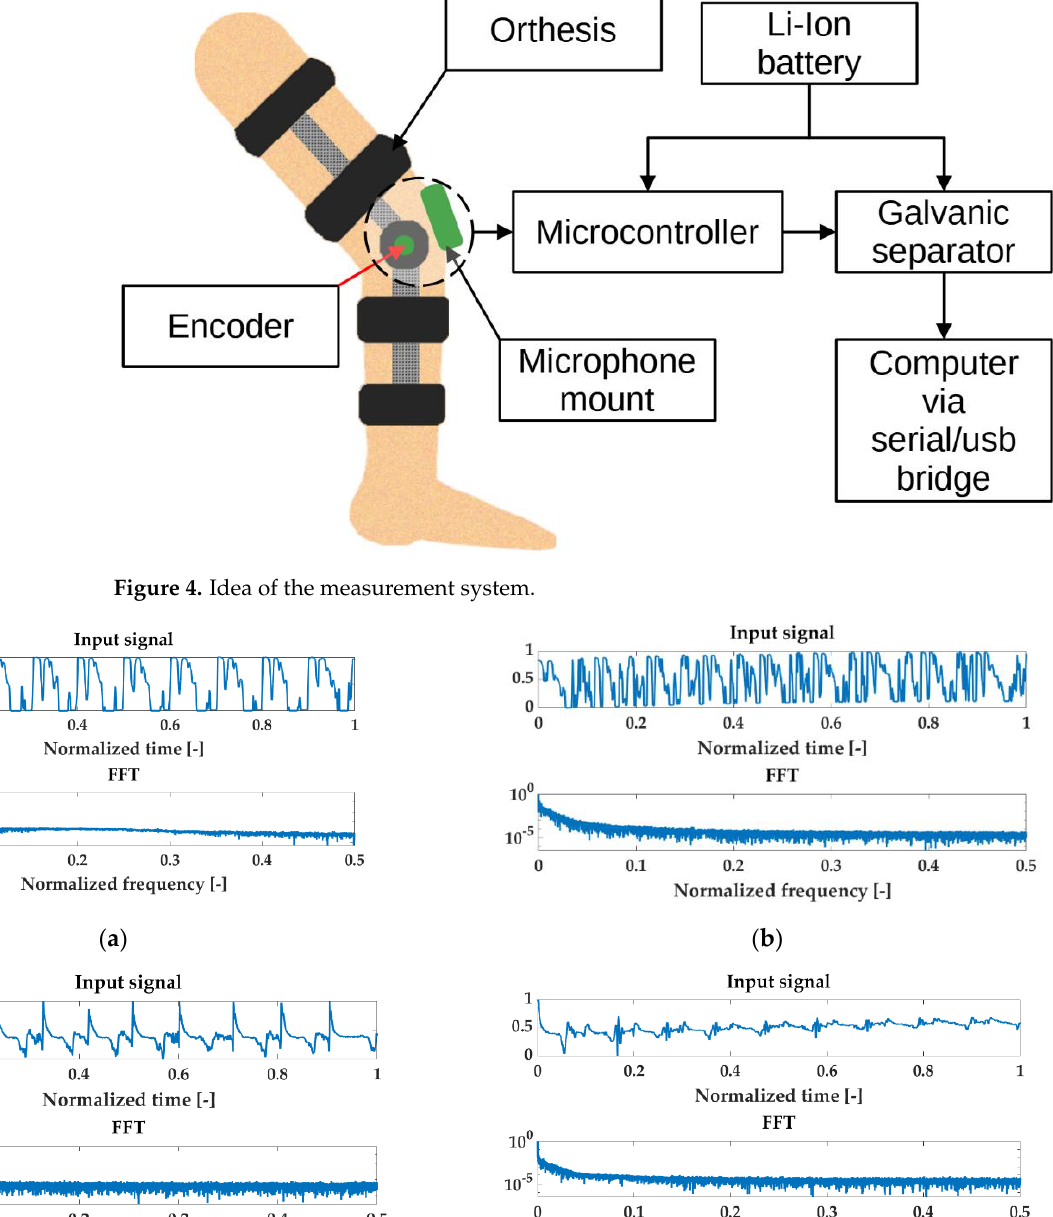
Figure 5. Examples of normalized signals for healthy (HC) and injured knees (OA) in the time and frequency domain for open kinetic chain (OKC) and closed kinetic chain (CKC) recorded with a sensor patella. Respectively: ( a ) HC OKC, ( b ) OA OKC, ( c ) HC CKC, and ( d ) OA CKC.